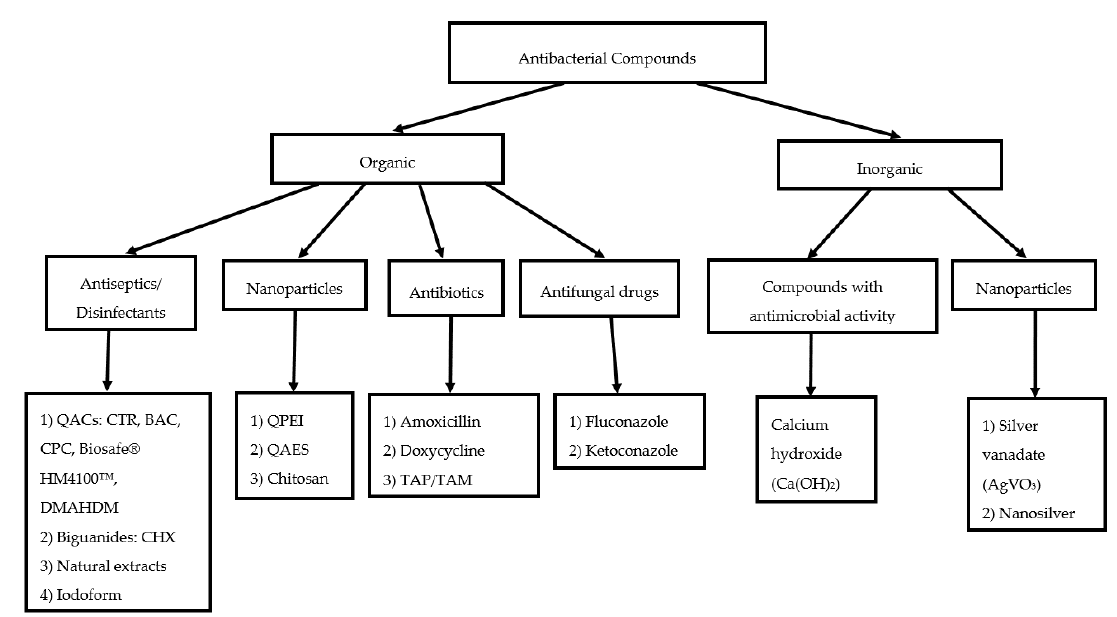
Figure 2. Classification of Antibacterial Compounds Discussed in the Review. Key: QACs = quaternary ammonium compounds; CTR = cetrimide; BAC = benzalkonium chloride; CPC = cetylpyridinium chloride; Biosafe ® HM4100 ™ = 3-(trihydroxysilyl)-propyldimethyloctadecyl ammonium chloride; DMAHDM = dimethylaminododecyl methacrylate; CHX = chlorhexidine digluconate; QPEI = quaternary ammonium polyethylenimine; QAES = quaternary ammonium epoxy silicate; TAP/TAM = triple antibiotic paste/mixture consisting of (minocycline or doxycycline) + metronidazole + ciprofloxacin.